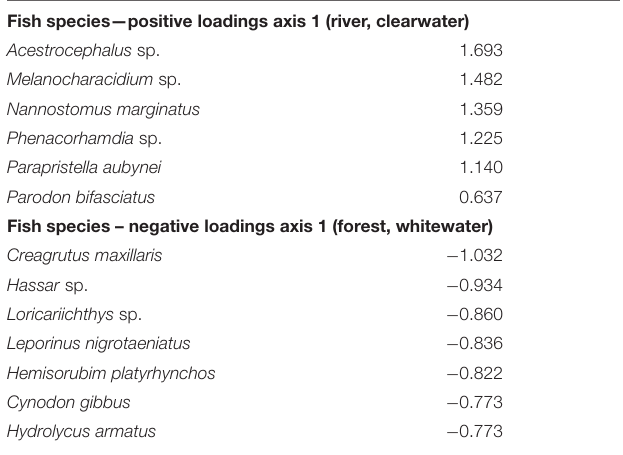
TABLE 3 | Canonical correspondence analysis (CCA) for species with highest loadings on axis 1 listed illustrating the relationship with fish species and habitat variables.